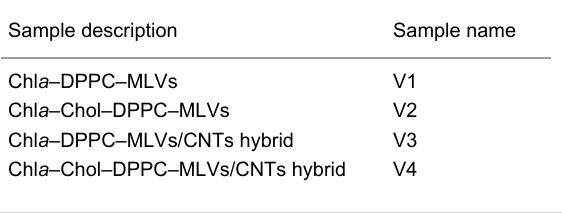
Table 1: The sample composition and abbreviations for the biostruc- tures prepared in this work.